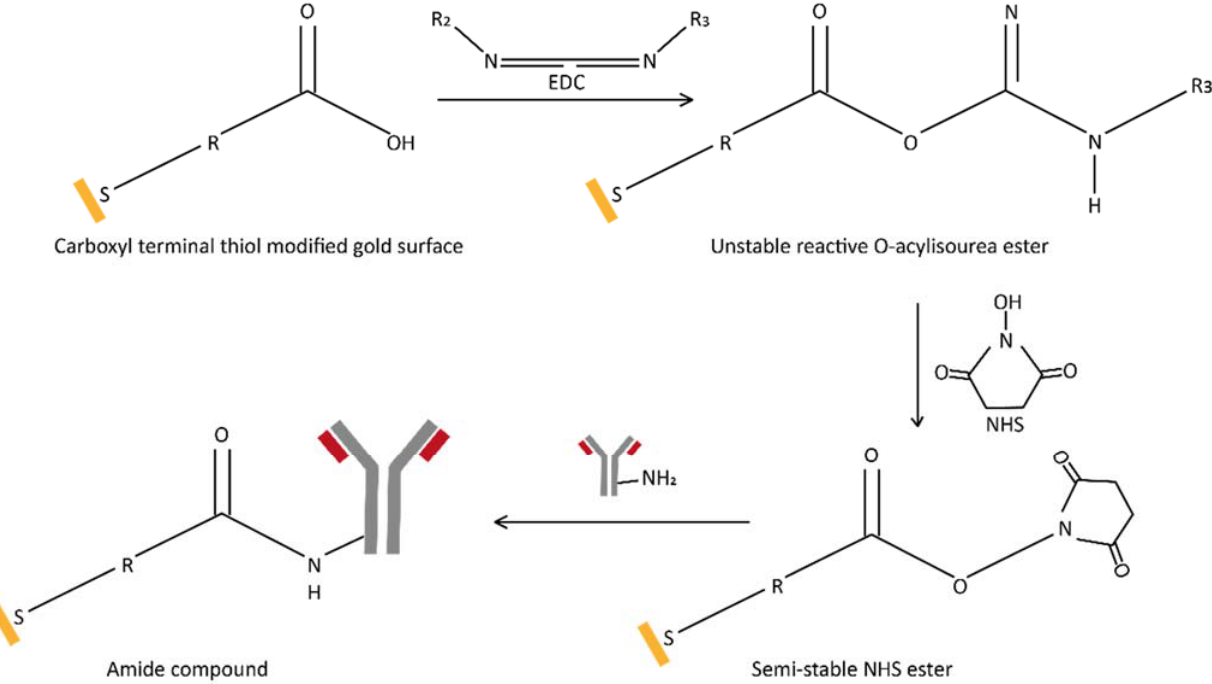
Figure 2. Strategy for immobilizing antibody to carboxylate-terminated SAM (11-MUA) on gold through EDC/NHS chemis-